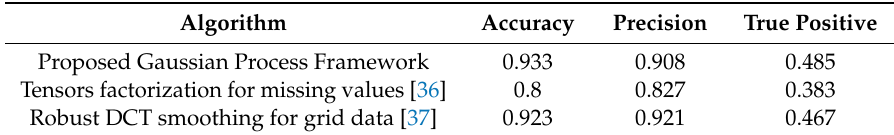
Table 1. Comparison of Different Resolution Matching Algorithms against the proposed Gaussian Process